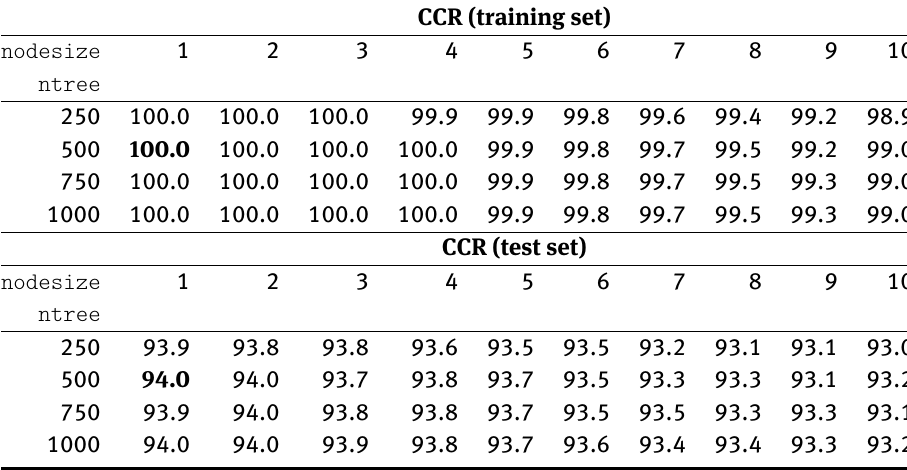
Table 6: Correct Classification Rate (CCR) obtained with Random Forest for several values of nodesize and ntree on the hand- written digit dataset. The CCR obtained with the default parameters nodesize=1 and ntree=500 are emphasized, and reported in Table 4. The training set includes τ = 63% individuals from the initial